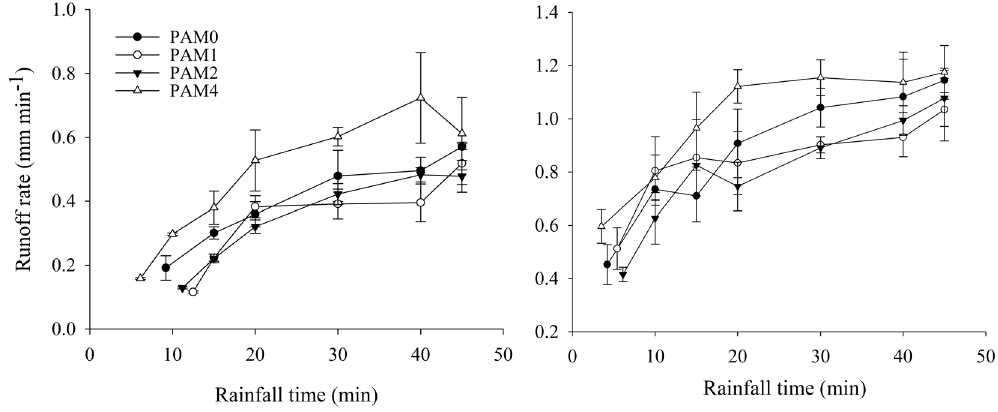
Figure 2. Mean runoff rates over rainfall time for the various treatments ( a ) r = 50 mm·h − 1 , ( b ) r = 80 mm·h − 1 .